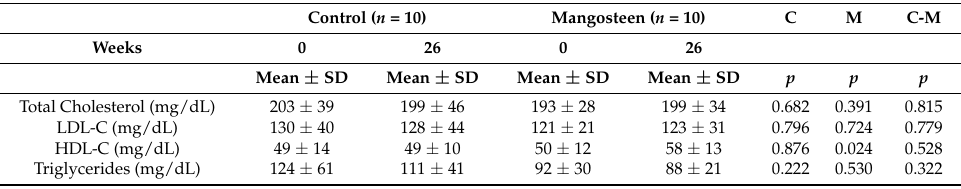
Table 3. Lipids profile of the treatment arms at baseline and 26 weeks. HDL levels increased from baseline in the mangosteen group ( p = 0.024), but comparison with control failed to show a statistically significant difference. No changes were observed regarding other serum lipids. C, outcome comparison of Control between 0 and 26 weeks; M, outcome comparison of mangosteen between 0 and 26 weeks; C-M, outcome comparison between control and mangosteen over time. Control ( n = 10)